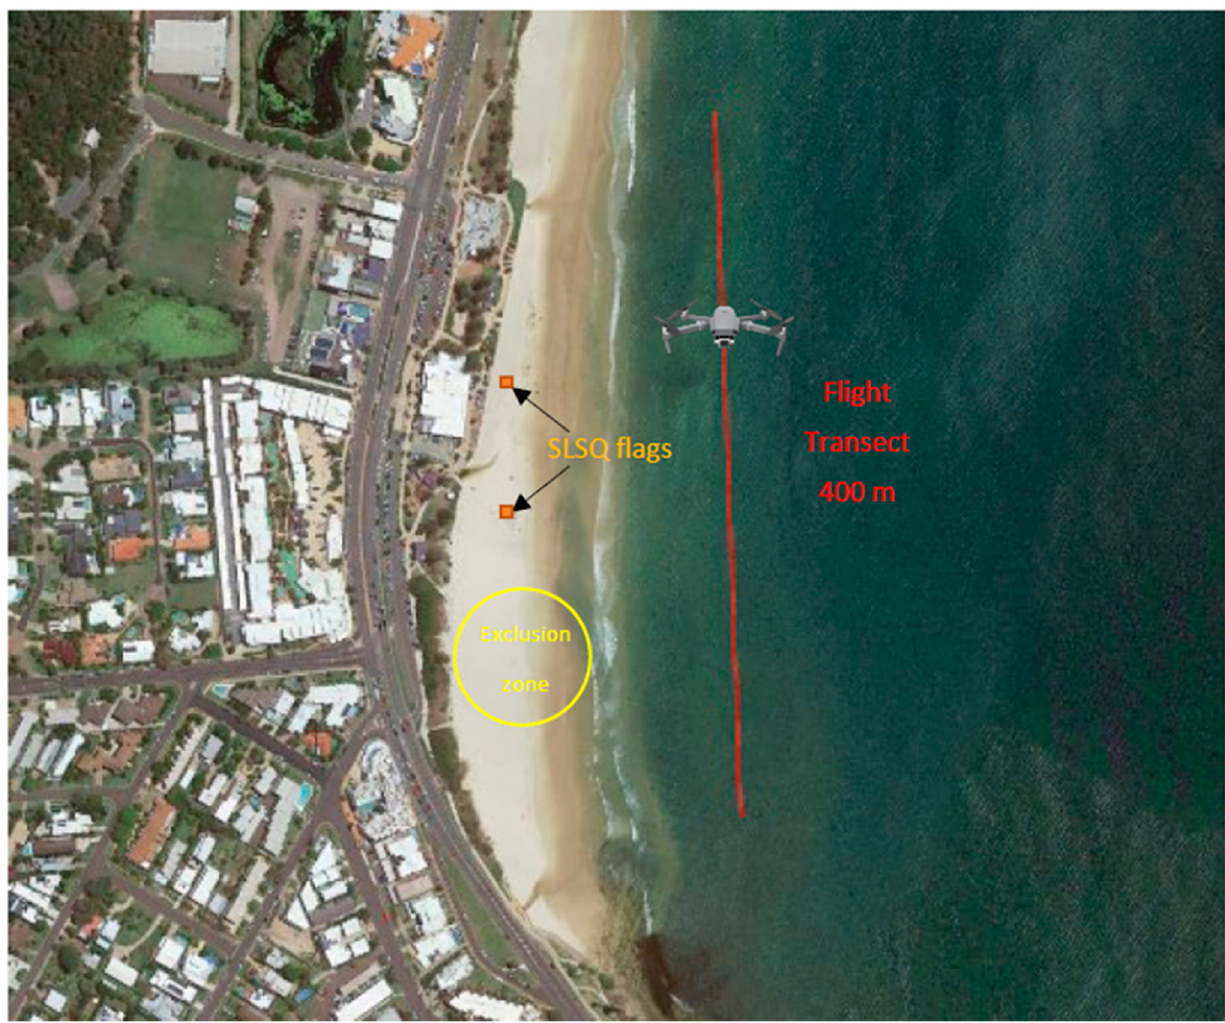
Figure 2. Schematic showing the position of drone transects relative to the flagged area of the beach.